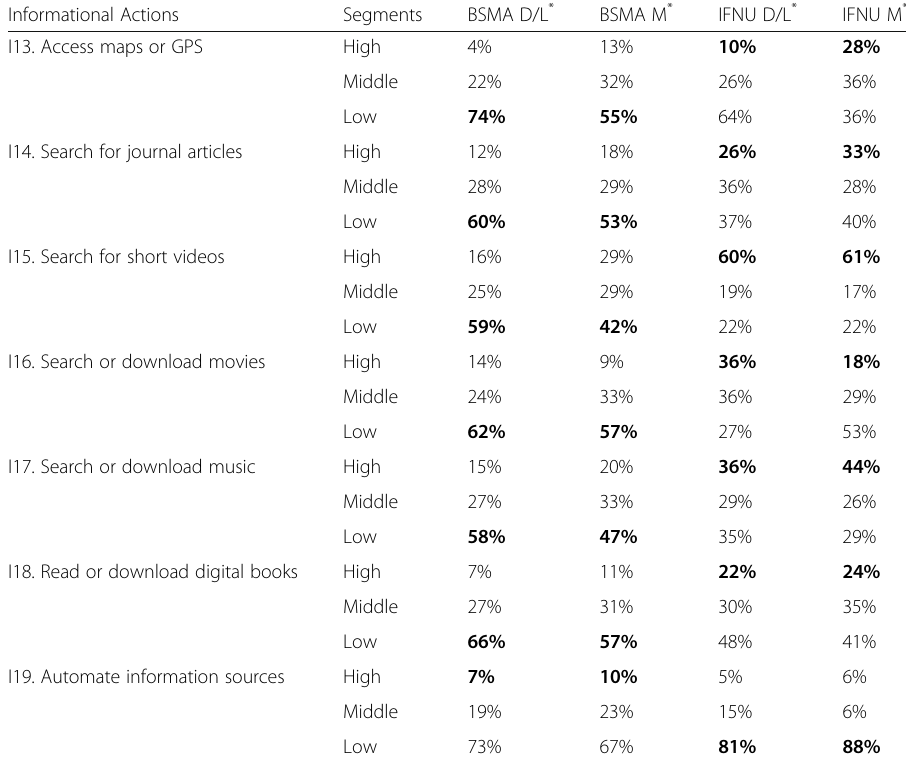
Table 4 Digital readiness segments for informational actions Informational